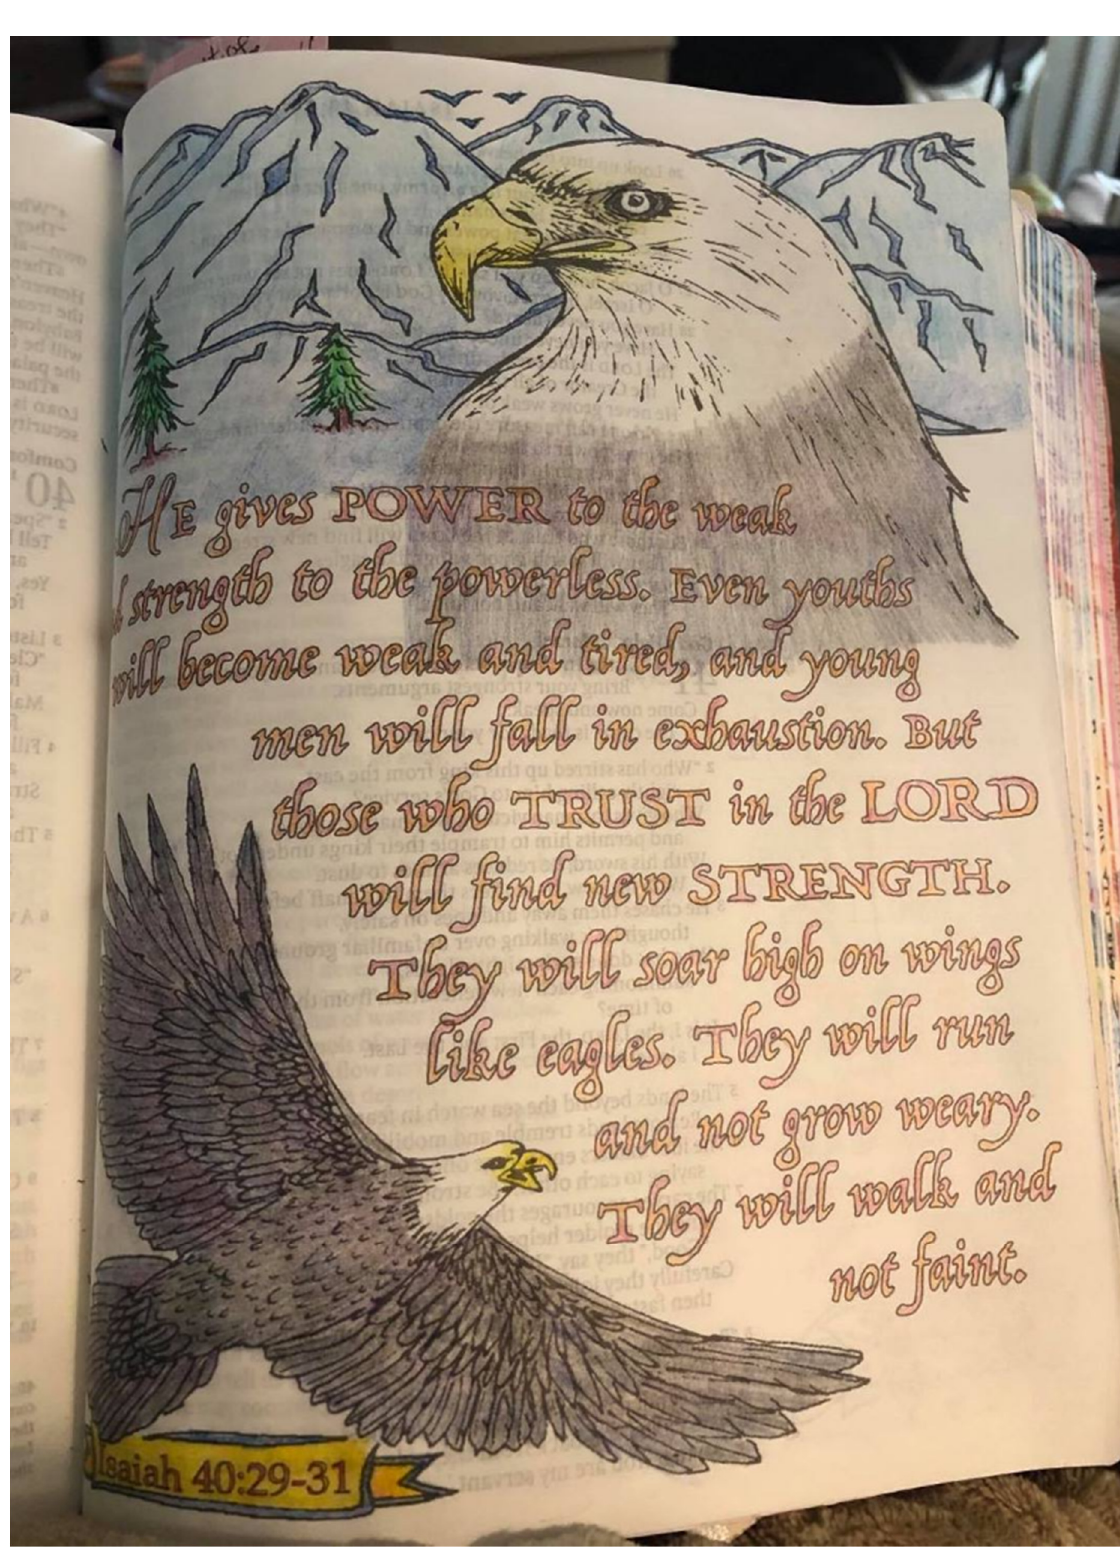
Figure 12. Isaiah 40:29–31. With kind permission of the journaler.